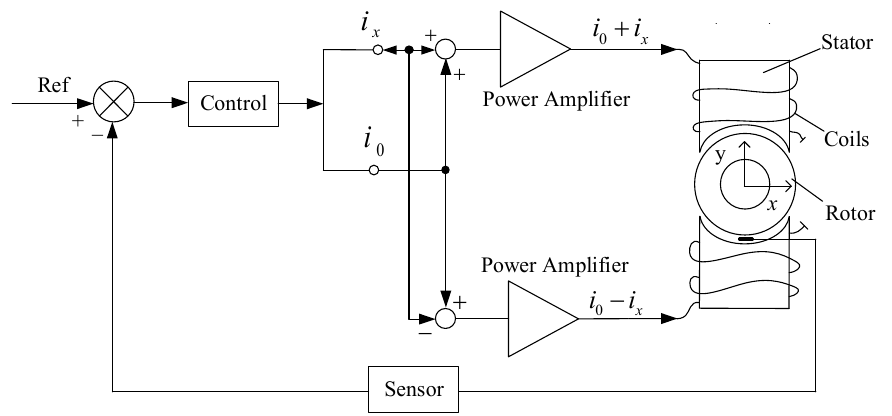
Figure 1. Working principle of an RMB system.